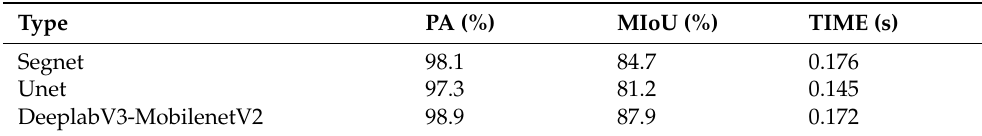
Table 2. Comparison of the